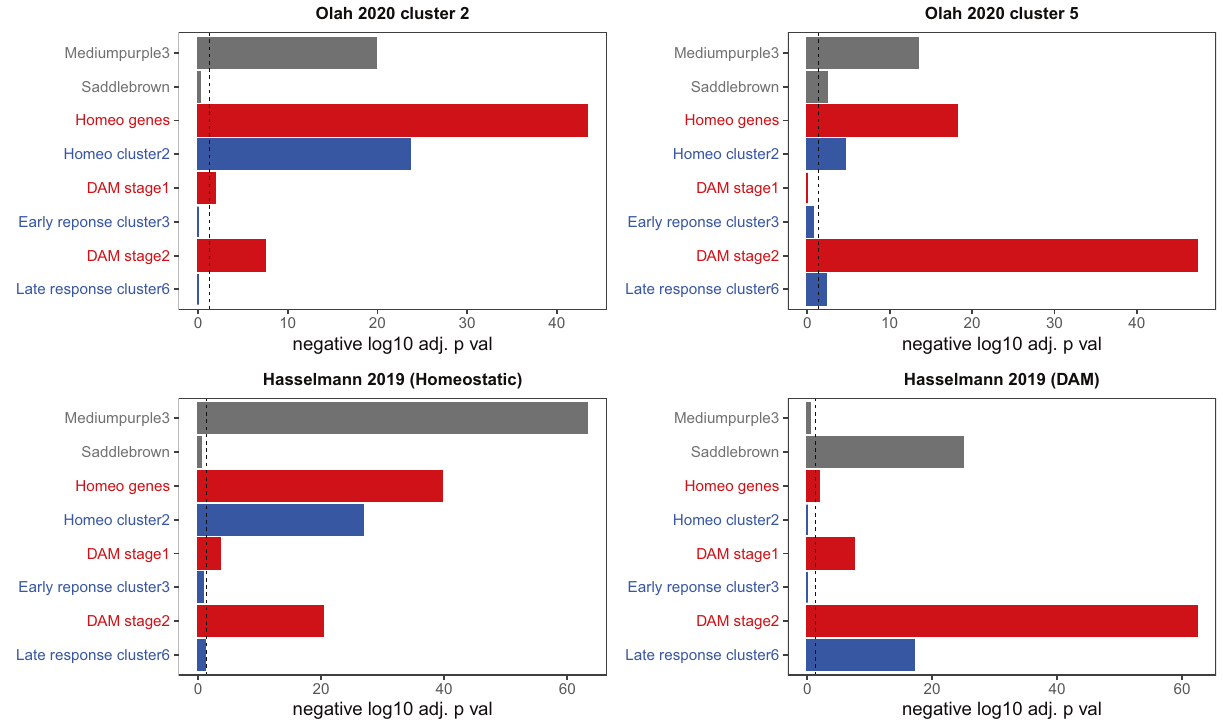
Fig. 7 Human single-cell microglial RNA-seq data is enriched for our NPH modules and mouse microglial gene lists. Clusters 2 and 5 are from single-cell sequencing of microglia from autopsy tissue (Olah et al. 20 ) and the homeostatic and DAM cluster de fi ning genes from Hasselmann et al. 43 are from a xenograph mouse model (see text for details). In each panel, the top two modules in gray ( mediumpurple3 and saddlebrown ) are NPH modules from this paper; mouse gene lists from Keren-Shaul et al. 37 (red) and Mathys et al. 38 (blue) are also shown. Cluster 2 from Olah et al. is the cluster from this paper most enriched for homeostatic genes from the mouse literature, and cluster 5 is most enriched for DAM stage 2 genes. Nevertheless, both clusters are also enriched for genes from opposing gene lists (i.e., cluster 2 is enriched for DAM stage 2 genes and cluster 5 is enriched for homeostatic genes), and both are enriched for mediumpurple3 . The homeostatic and DAM xenograph clusters are enriched exclusively for mediumpurple3 and saddlebrown , although even here there is some crossover enrichment with mouse lists (i.e., DAM stage 2 gene enrichment with the homeostatic cluster). See main text for discussion and Supplementary Data 7 for all analyses with these datasets, including the analysis displayed in this fi gure. Each analysis in this fi gure uses a two-sided Fisher ’ s exact test and is separately Bonferroni adjusted — dotted line in all panels is p value =